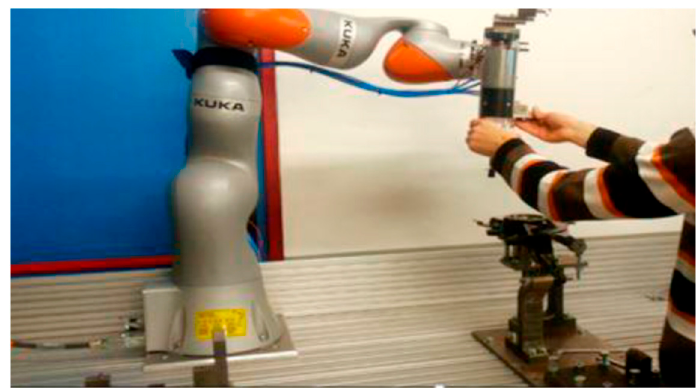
Figure 1. Human–robot collaboration system based on hand motion [25].